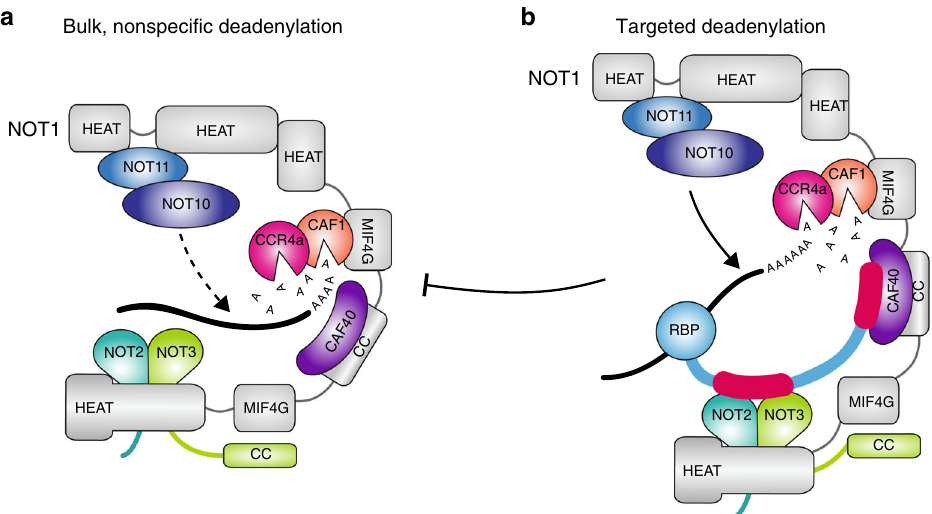
Fig. 7 A proposed mechanistic model for the switch from bulk to targeted deadenylation. a The CCR4-NOT complex possesses intrinsic af fi nity towards nucleic acids which allows it to bind to and deadenylate bulk mRNAs in a manner independent of the sequence of the RNA. In addition to the active sites of the nucleases, also the CAF40 module, the NOT module, and the NOT10:NOT11 module can directly interact with the substrate and contribute to a different extent to the stimulation of deadenylation, with CAF40 being the dominant stimulatory site under the conditions of our in vitro assays. b Upon stimulation, RNA-binding proteins (RBPs) can recruit the CCR4-NOT complex to speci fi c transcripts via direct protein-protein interactions and trigger the preferred deadenylation of those transcripts. In addition, RBPs carrying a CAF40-binding motif can mask the RNA-binding site on CAF40, thereby gaining further competitive advantage for deadenylation of their bound mRNA over other, nonspeci fi c transcripts in the cytoplasmic mRNA